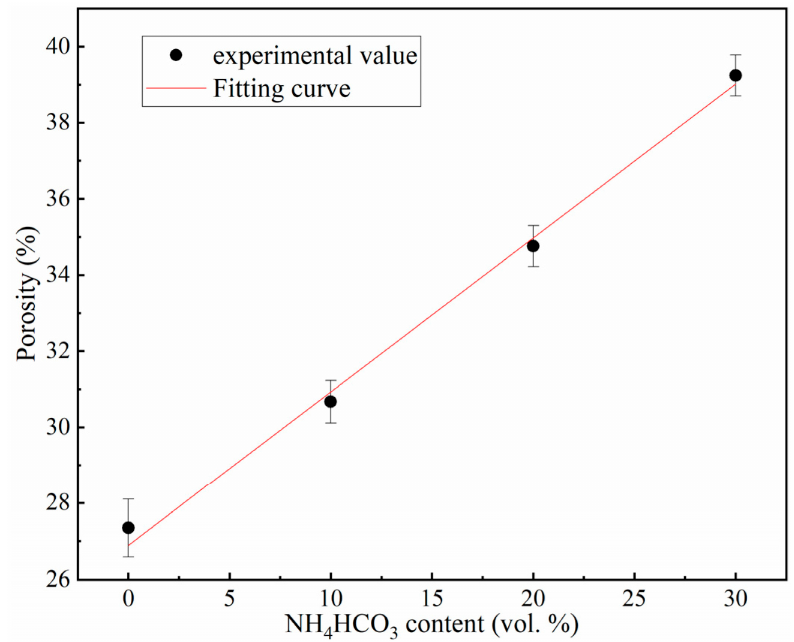
Figure 4. The relationship between the porosity of the SiC preform and the content of NH 4 HCO 3 .